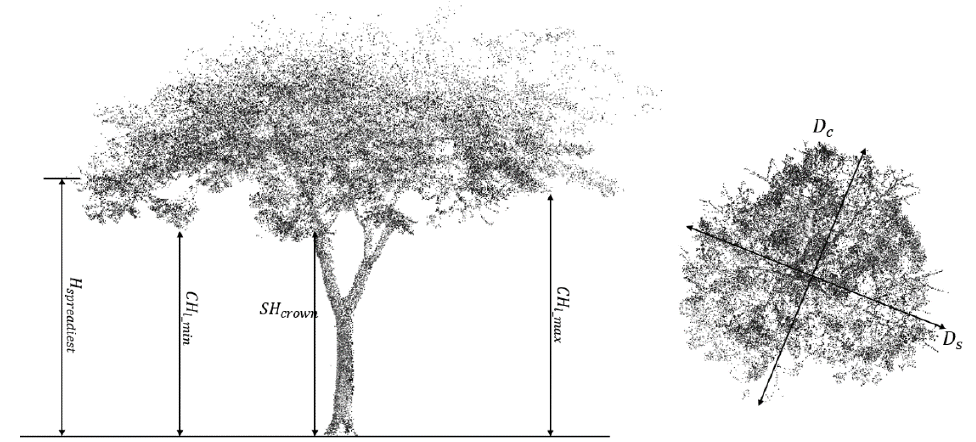
Figure 3. Illustration of crown parameters. H spreadiest is the height with the largest projection area. CH l _ min and CH l _ max are the minimum and maximum height of low crown, respectively. SH crown is crown start height. D s and D c are the maximum crown spread and maximum crown cross-spread, respectively.